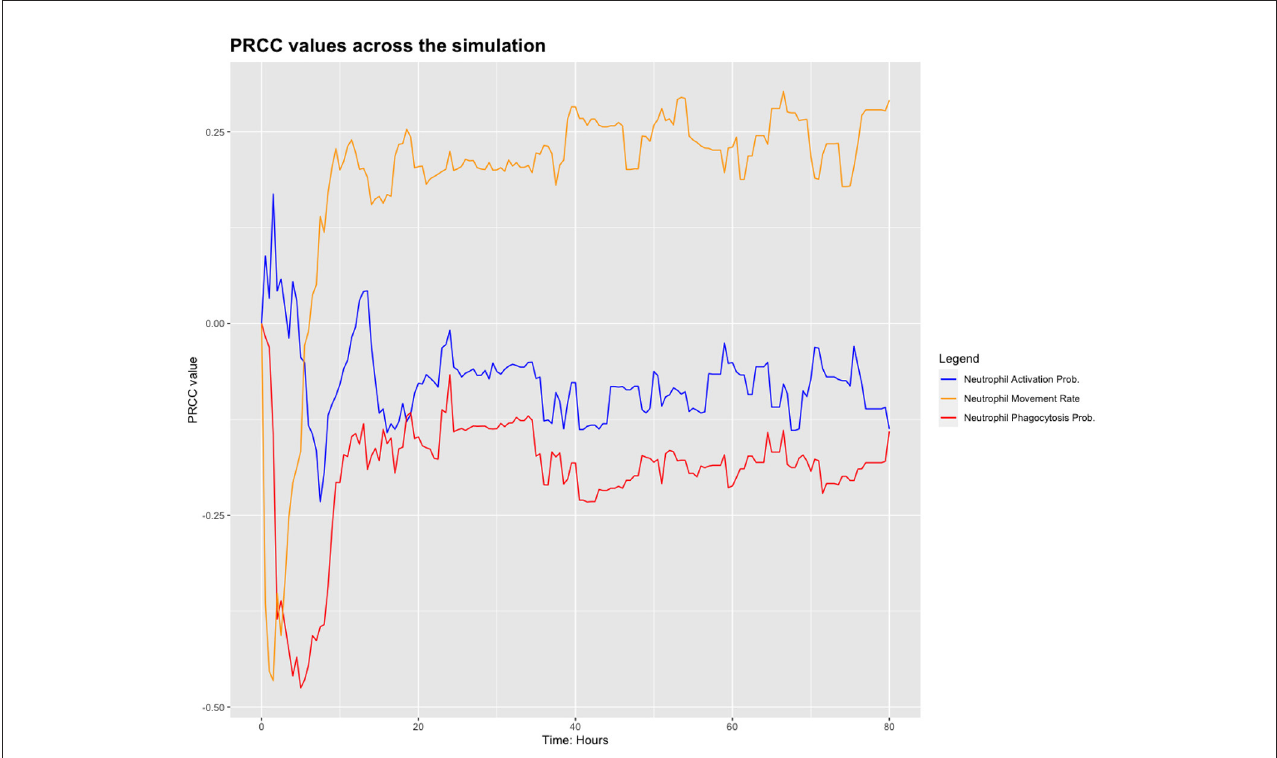
FIGURE4 PRCC values for neutrophil parameters.